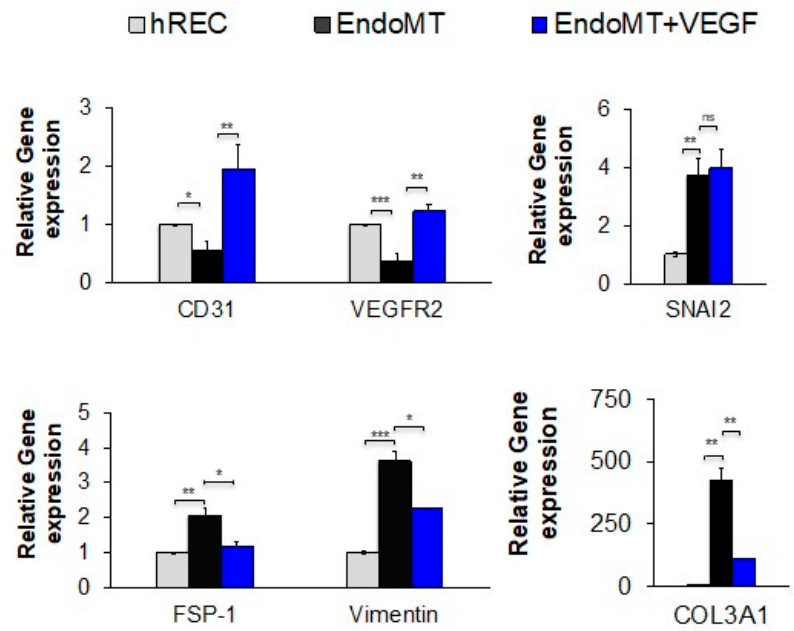
Figure 2. Treatment with VEGFA at a high concentration significantly reduces expression of genes associated with EndoMT and restores gene expression associated with endothelial cell differentiation. After EndoMT induction using IL-1 β (0.1 ng/mL), TNF- α (5.0 ng/mL), and TGF- β 2 (5.0 ng/mL), EndoMT cells were cultured for seven days in medium containing 5% FBS and 1% penicillin/streptomycin in the presence or absence of VEGFA165 (50 ng/mL). Expression levels for